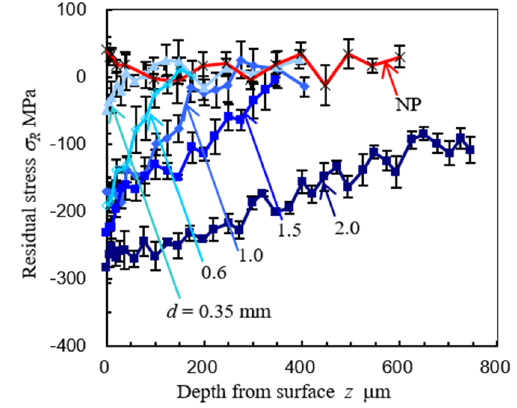
Figure 15. Effect of nozzle diameter on introduction of compressive residual stress compared with non-peened (NP) (stainless steel) [100].